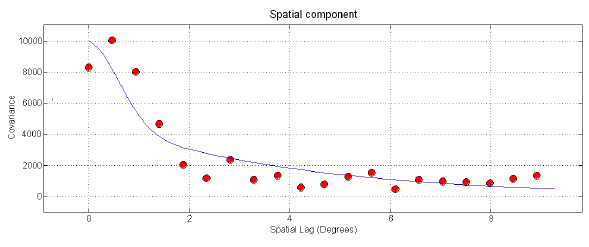
Fig. 3. The spatial experimental covariance and nested spatial co- variance model.